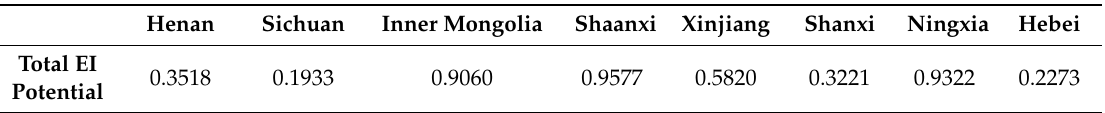
Table 8. Total environmental impact (EI) potential of the liquefied natural gas production in the eight provinces of China (p · a). Henan Sichuan Inner Mongolia Shaanxi Xinjiang Shanxi Ningxia